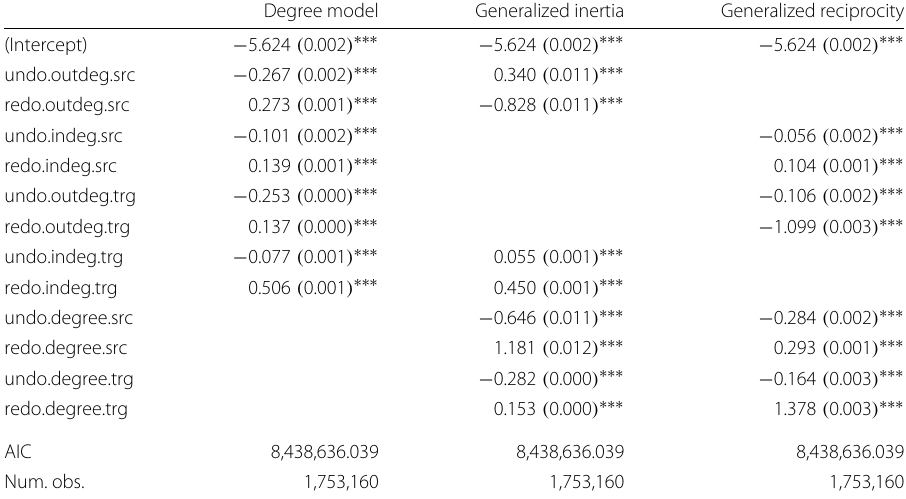
Table 7 Explaining dyadic redo by past undo and redo on dyads incident to source and target (degree